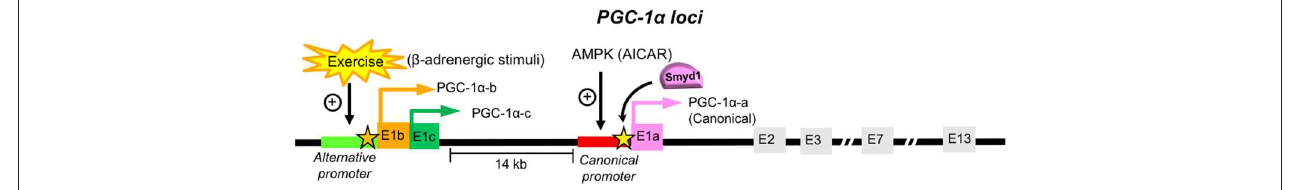
FIGURE 4 | PGC-1 α promoters and isoforms. The PGC-1 α loci contains two promoters in the skeletal muscle: the canonical and alternative promoters [Reviewed in (128)]. Transcription initiated from the upstream alternative promoter of the PGC-1 α gene results in the inclusion of new exons E1b or E1c, which generate PGC-1 α -b and PGC-1 α -c, respectively. The PGC-1 α -b and PGC-1 α -c proteins contain two distinct N-termini, which are different from the canonical PGC-1 α -a derived from the exon (E1a) from the canonical promoter. Exercise increases the PGC-1 α mRNA levels originated from the alternative promoter , which is correlated with the elevated H3K4me3 marks in the alternative promoter region of PGC-1 α (110) (indicated with an orange star). However, it remains elusive what histone methylation modifiers are responsible for the increase of the H3K4me3 levels on the alternative protomer of PGC-1 α by exercise. In our previous study, the enrichment of the H3K4me3 marks were assessed in the Smyd1-knockout mouse heart, which was reduced at the canonical promoter ( ∼− 1kb from E1a, indicated with a yellow star), suggesting that Smyd1 regulates the expression of the PGC-1 α -a mRNA isoform in the heart. It remains unknown whether the PGC-1 α variants from the alternative promoter are involved in metabolic remodeling in the hypertrophied and failing